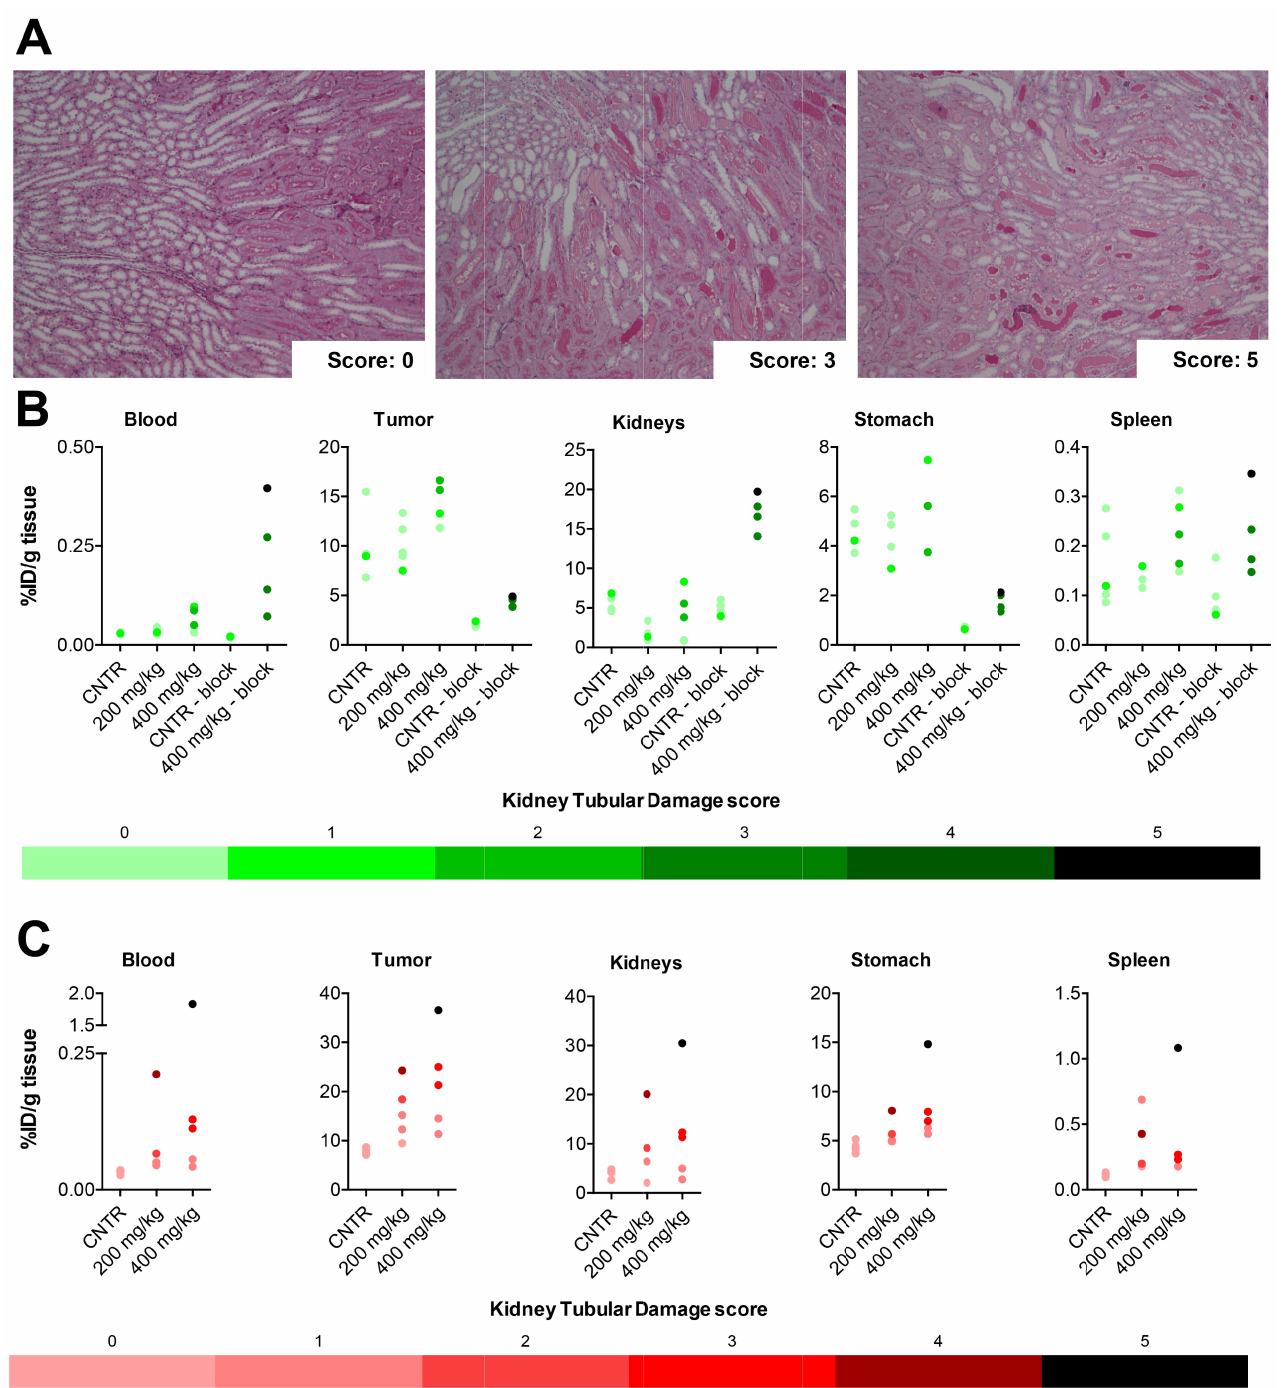
Figure 4. Biodistribution correlated with the observed renal-tubular-damage Kidneys were scored for renal tubular damage on a 5-point scale ( A ). Biodistribution data were correlated with the renal tubular damage score for blood, tumor, kidneys, stomach and spleen of mice treated with vehicle or VPA (200 mg/kg or 400 mg/kg) four ( B ) or eight ( C ) hours prior to [ 177 Lu]Lu-DOTATATE administration. A color gradient is used to indicate the level of damage. Each data point in these graphs represents a mouse. For the uptake of [ 177 Lu]Lu-DOTATATE in kidneys, the average of both kidneys is plotted. Outliers based on % ID/g tissue are included in this